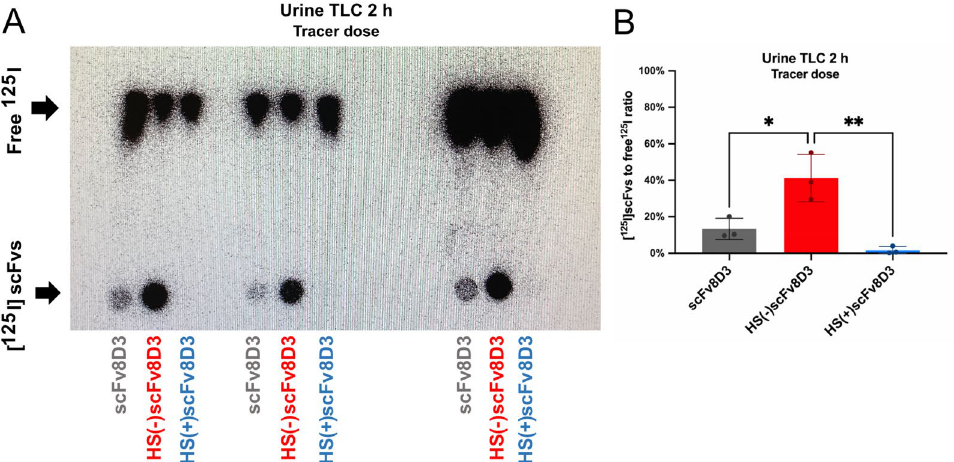
Figure 10. Urine Thin-Layer Chromatography quality controls of [ 125 I]scFvs constructs. ( A ) The urine TLC quality control of the radiolabeled scFvs [ 125 I]scFv8D3, (n = 3), [ 125 I]HS(−)scFv8D3 (n = 3) and [ 125 I]HS(+) scFv8D3 (n = 3) 2 h post-injection. ( B ) Semi-quantitative analysis of the ratio between the [ 125 I]scFvs to free 125 I by measuring optical density of the TLC signal with Fiji (ImageJ) 44 . Results are presented as mean ± SD and statistical comparisons were conducted between the three [ 125 I]scFvs. * Represents a significance of P < 0.05, ** Represents a significance level of P < 0.01. Full sized image of TLC membrane in supplementary Fig. S2. Low exposure image of TLC membrane in supplementary Fig. S3.